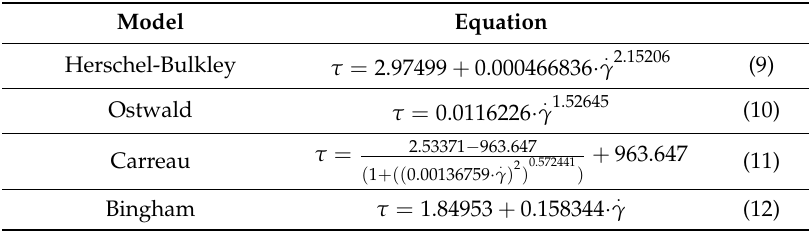
Table 4. Mathematical formulas of rheological models for the E21 alloy.